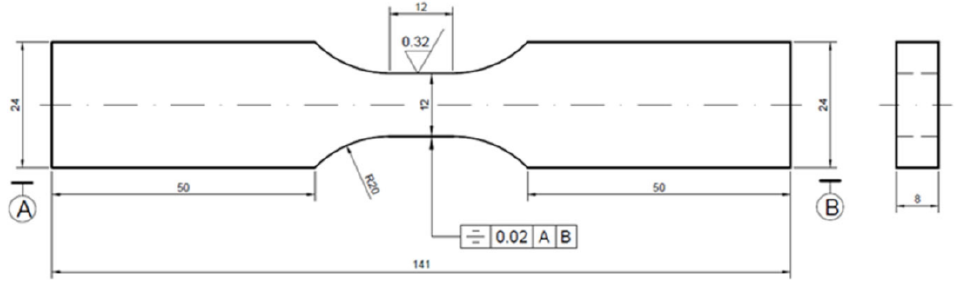
Figure 1. Detailed dimensions of specimens.